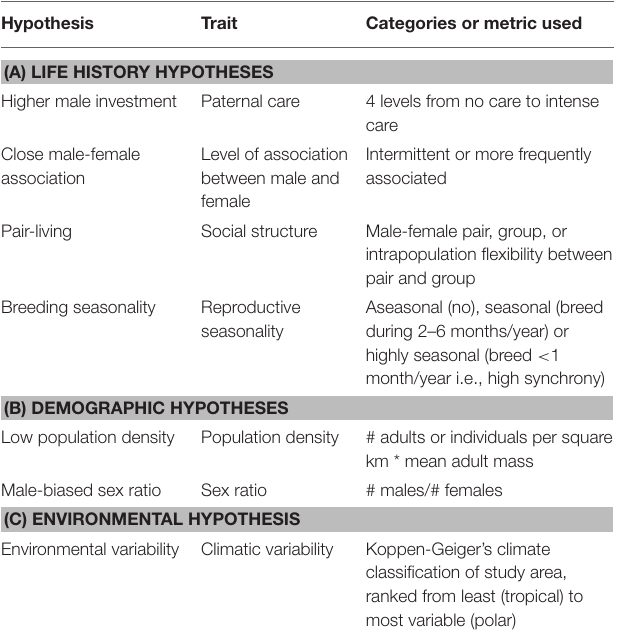
TABLE 1 | Hypotheses* proposed to explain genetic monogamy in mammals. Hypothesis